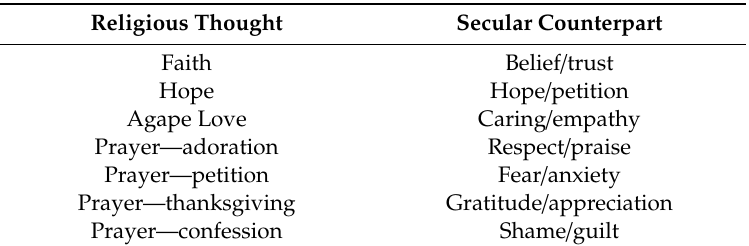
Table 1. Religious Thought Categorized in Secular